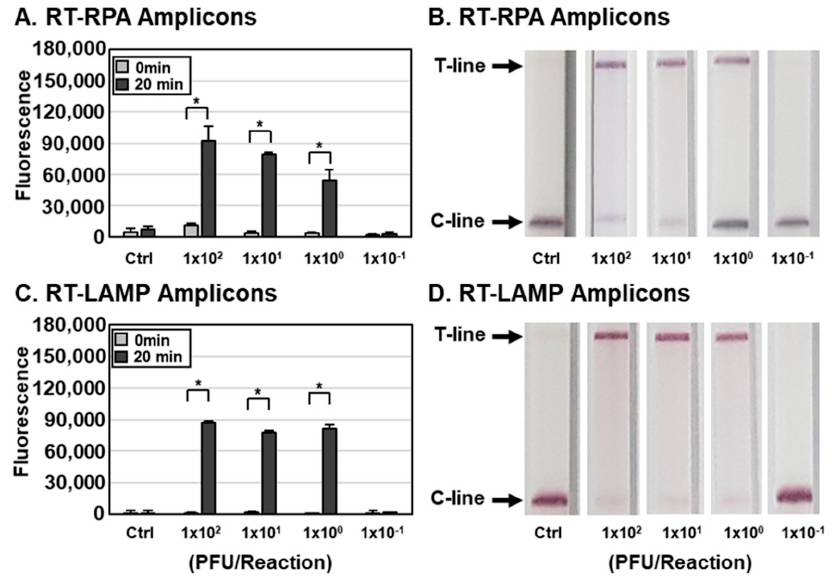
Figure 3. Sensitivity of the DETECTR assay for IAV. ( A – D ) Different concentrations of IAVs (1.0 × 10 − 1 to 1.0 × 10 4 PFUs per reaction) were used to amplify viral nucleic acids using either RT-RPA ( A , B ) or RT-LAMP ( C , D ) with primer sets specific for the IAV M gene. RT-RPA and RT-LAMP amplicons were detected by DETECTR combined with fluorescence ( A , C ) or lateral flow ( B , D ) assays using gRNAs targeting the IAV M gene. The fluorescence signals of DETECTR on RT-RPA or RT-LAMP amplicons were saturated within 20 min. Lateral flow assay results were assessed 2 min after inserting the strip into the sample. Values are presented as means ± s.d (error bars) ( n = 3 replicates; * p < 0.05 between samples, two-sample t -test). C-line, control line; T-line, test line; Ctrl, control.